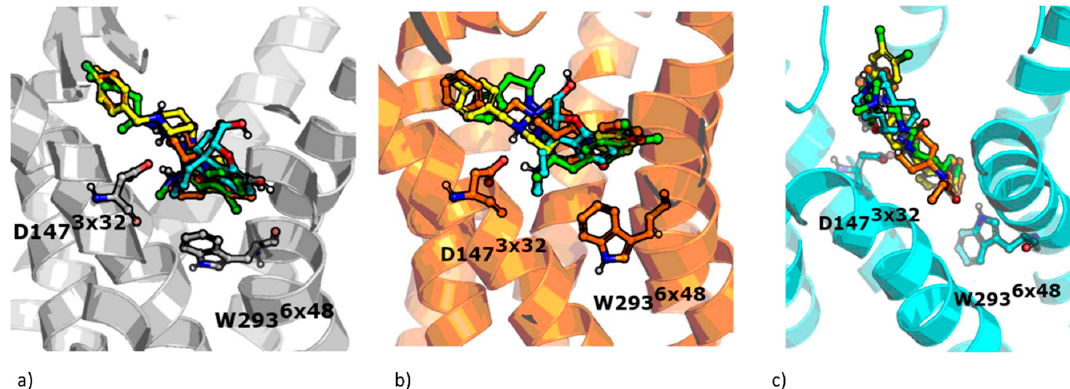
Figure 3. Docking poses of examined compounds at µ opioid receptor crystal structures, ( a ) 4DKL, ( b ) 5C1M, ( c ) 6DDF. PZM21: green; SR-17018: yellow; morphine: cyan; fentanyl: orange. GPCRdb numbering scheme for amino acid labeling is used. Coloring of particular crystal structures is consistent through the whole manuscript. Molecules 2020 , 25 , x